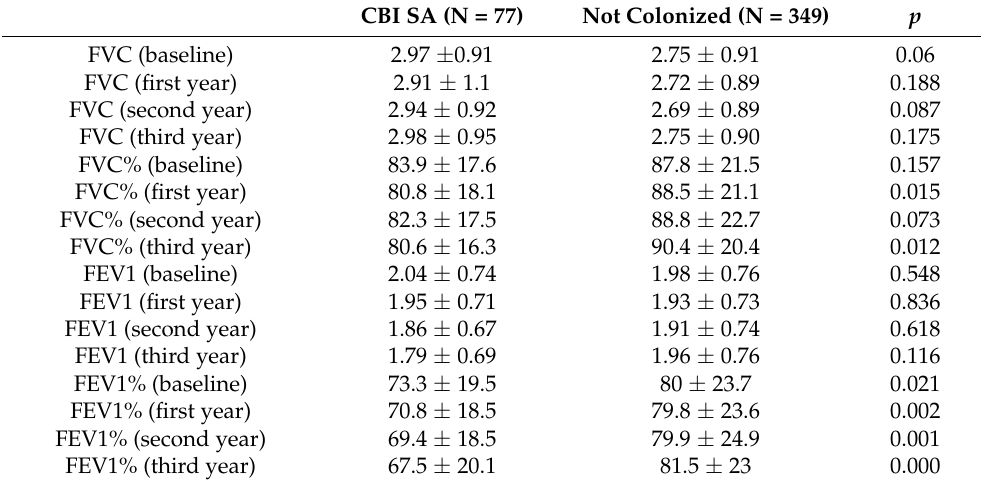
Table 3. Pulmonary function test